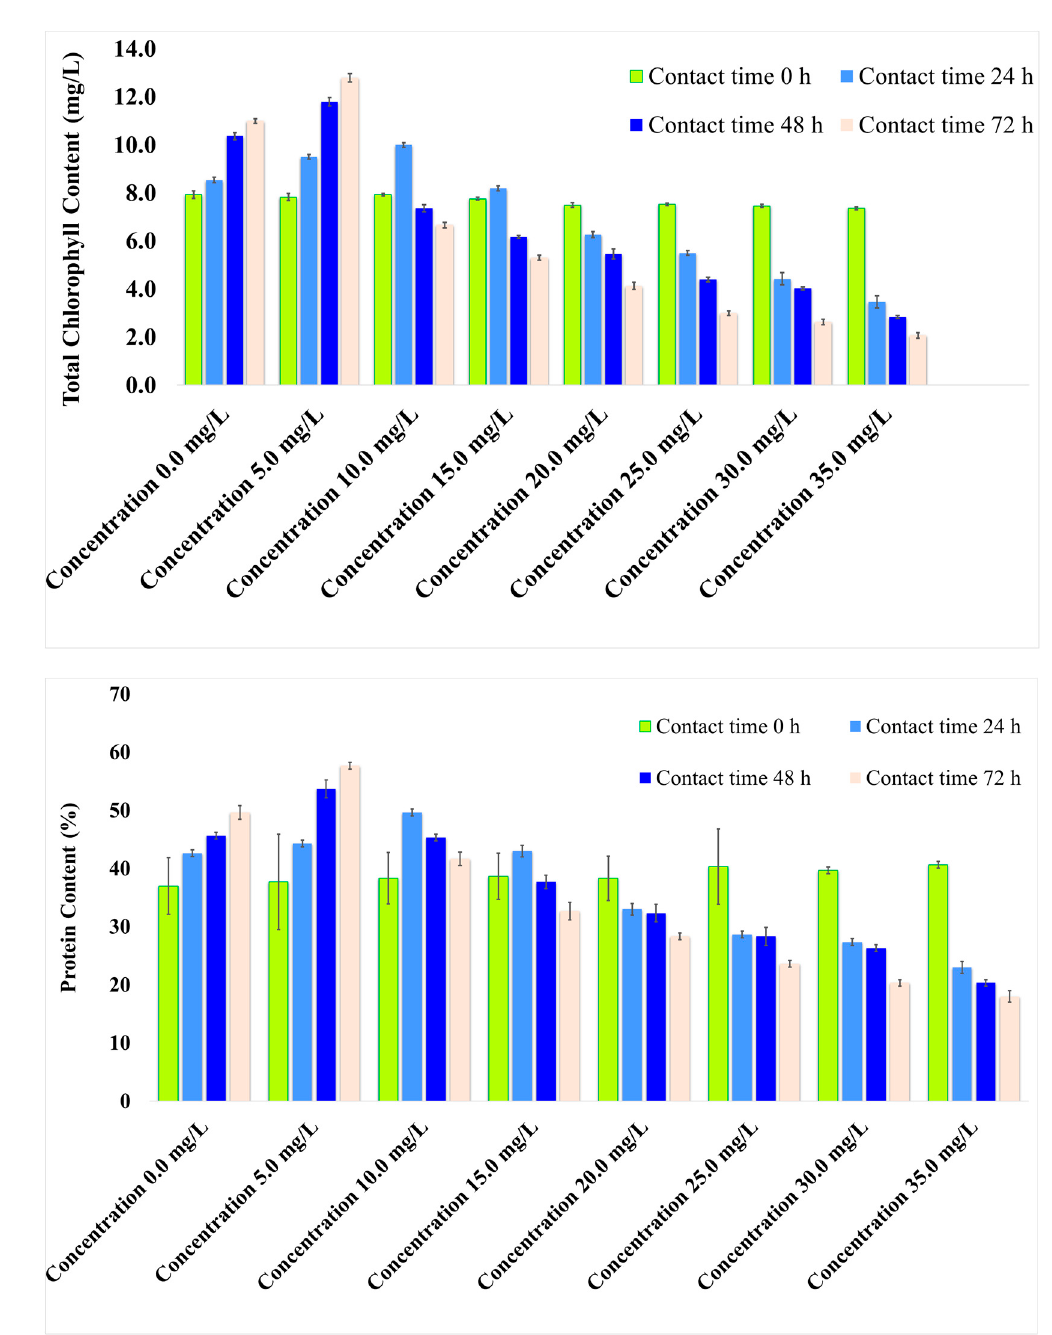
Figure 6. The effects of CAF and DEET on ( a ) chlorophyl and ( b ) protein content in microalgae.